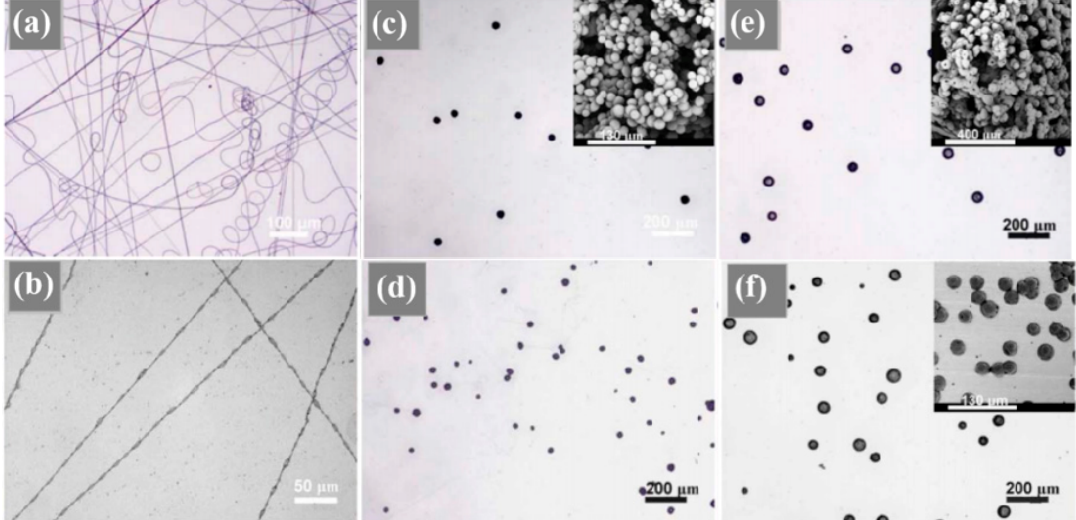
Figure 5. The effects of polymer molecular weight and solution concentration on the results of PCL electrospraying ( a ) smooth fibers from PCL with 80,000 g/mol, 10 wt.%; ( b ) beaded fibers from PCL with 80,000 g/mol, 0.5 wt.%; ( c ) particles from PCL with 45,000 g/mol, 9 wt.%; ( d ) particles from PCL with 45,000 g/mol, 11 wt.%; ( e ) particles with fibrils from PCL with 45,000 g/mol, 30 wt.%; ( f ) particles from PCL with 10,000 g/mol, 30 wt.% (reprinted with permission from Taylor & Francis Ltd., http://www.tandfonline.com [98]).